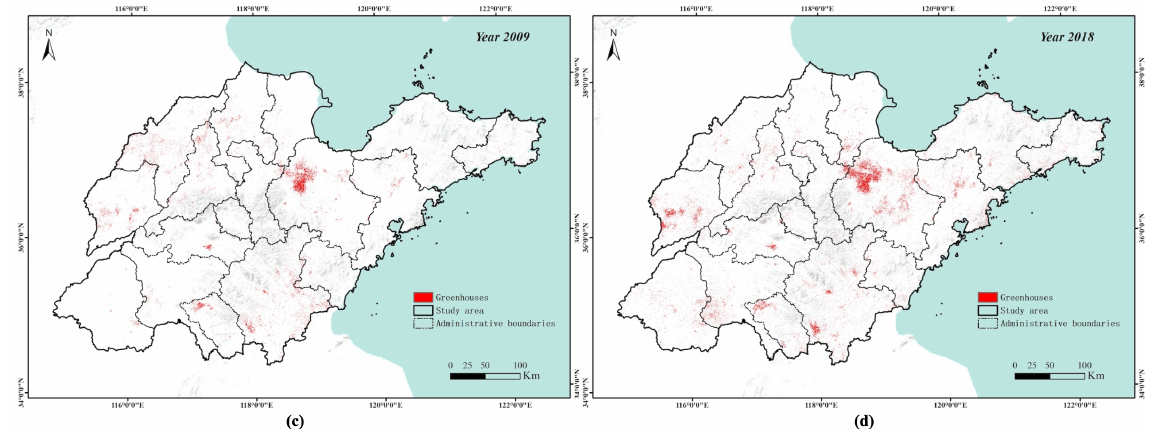
Figure 15. Spatial distribution of AG in Shandong province, China in 1989 ( a ), 1999 ( b ), 2009 ( c ) and 2018 ( d ).